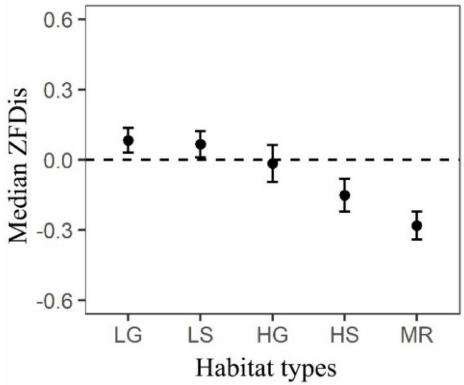
Figure 3. Standardized e ff ect sizes of functional dispersion (ZFDis) of a multivariate trait (AT) for all trees across five habitat types at 20 m × 20 m spatial scale. See Figure 2 for interpretation